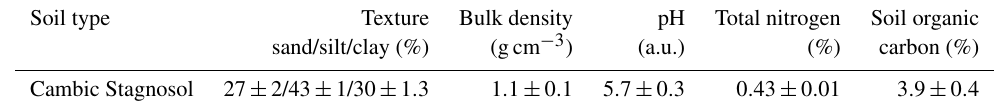
Table 1. Soil characterization of the research site Fendt. Values are given for the topsoil (0–10cm) according to Kiese et al. (2018). Soil type Texture Bulk density pH Total nitrogen Soil